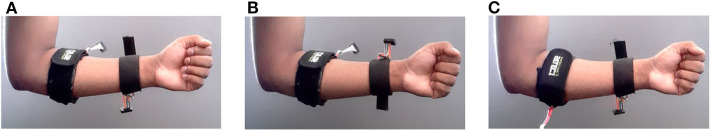
Three placements of sensor bands, (A) two FSR1 from SBe and SBw are aligned with brachioradialis and near insertion of brachioradialis, (B) aligned with brachioradialis and flexor carpi ulnaris, (C) aligned with palmaris longus and near insertion of brachioradialis.